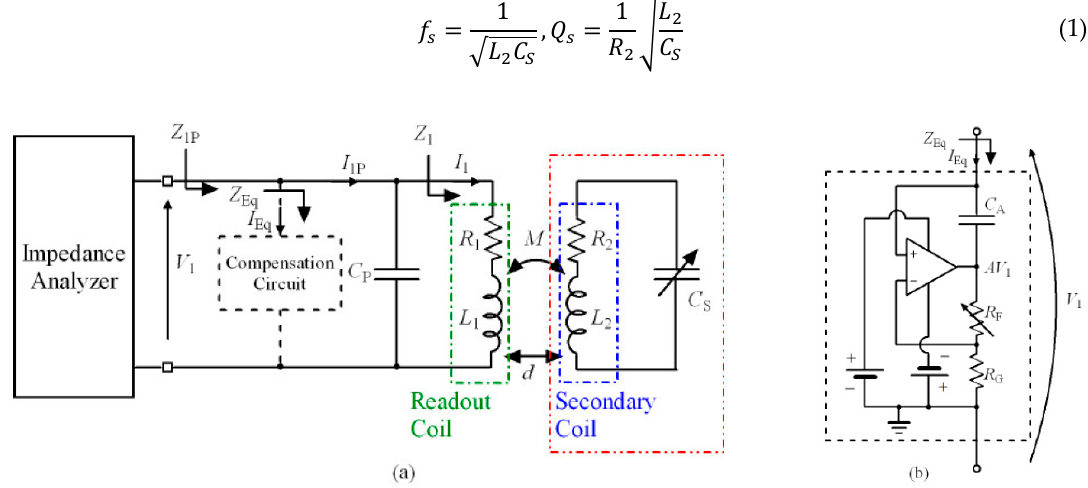
Figure 1. ( a ) Schematic diagram of the contactless readout system. ( b ) Capacitance compensation